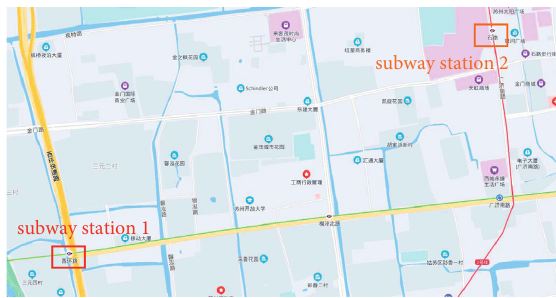
Figure 6: Part of the subway route map.